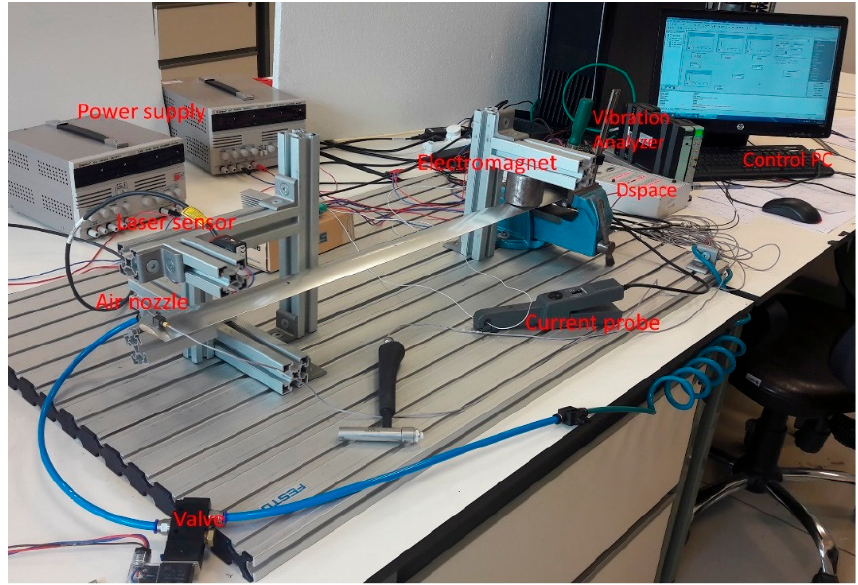
Figure 14. Experimental system setup.